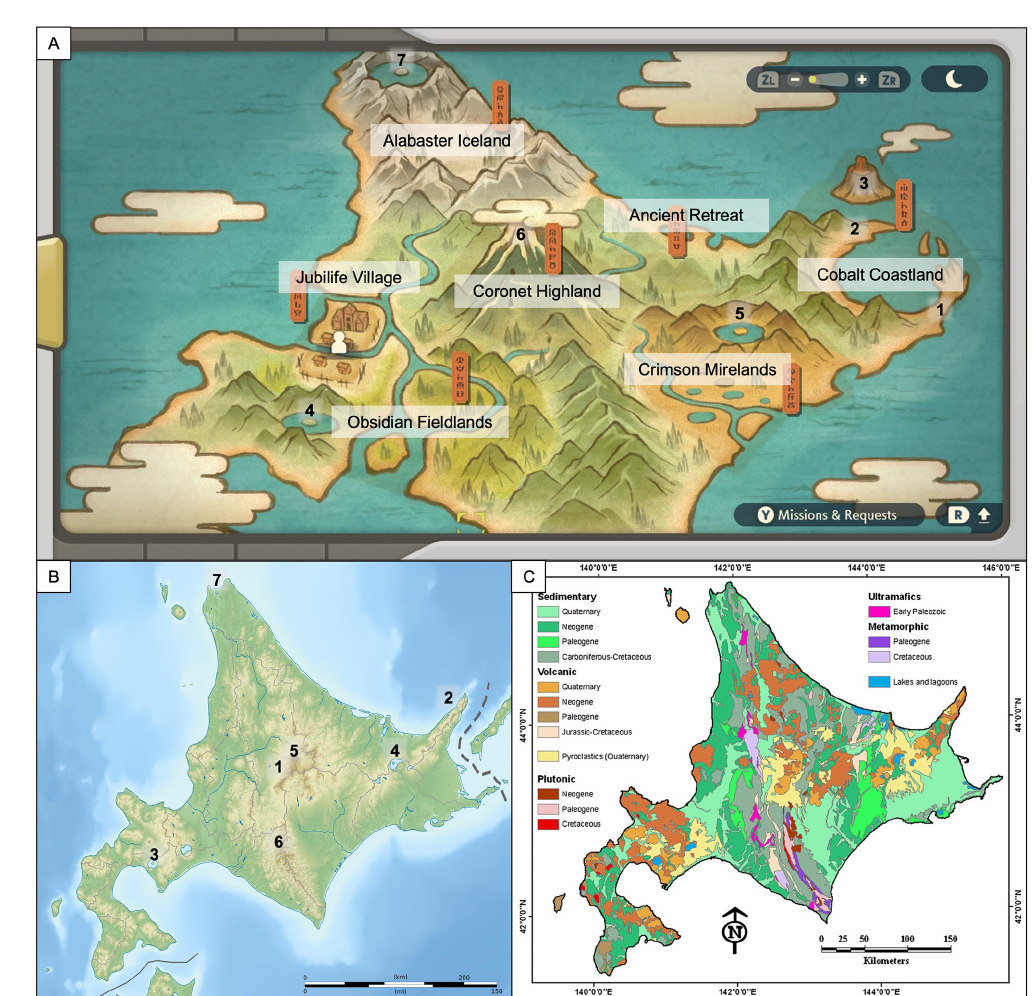
Figure 1. Topographic maps of Hisui, Pokémon Legends: Arceus , and Hokkaido, Japan. (a) Annotated in-game map of Hisui from Pokémon Legends: Arceus . Note the non-traditional angle of viewing and artistic style. (1) Deadwood Haunt, (2) Veilstone Cape, (3) Firespit Island, (4) Lake Verity, (5) Lake Valor, (6) Mt Coronet, (7) Lake Acuity ©The Pokémon Company International (2022a). (b) Terrain map of Hokkaido, Japan (1) Biei Blue Pond, (2) Shiretoko Peninsula, (3) Lake T¯oya, (4) Lake Kussharo, (5) Mt Asahi, (6) Hidaka Mountains, (7) Lake Onuma (Bourrichon, 2019). (c) Geological map of Hokkaido, Japan (Ayalew et al.,